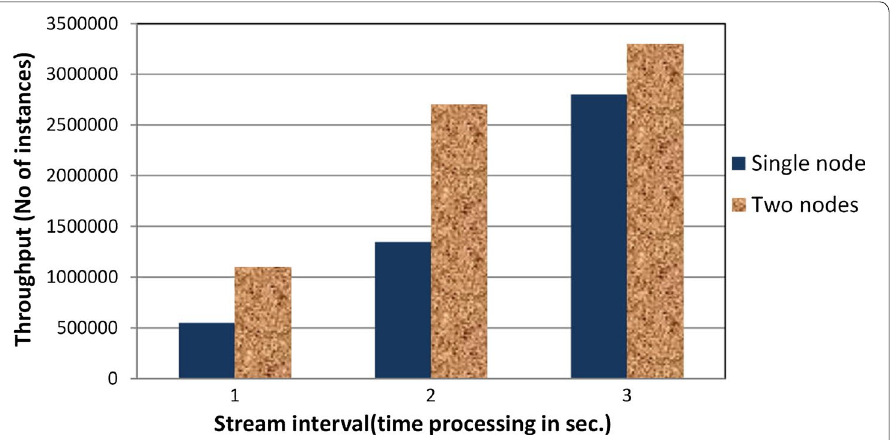
Fig. 16 Performance evaluation: processing